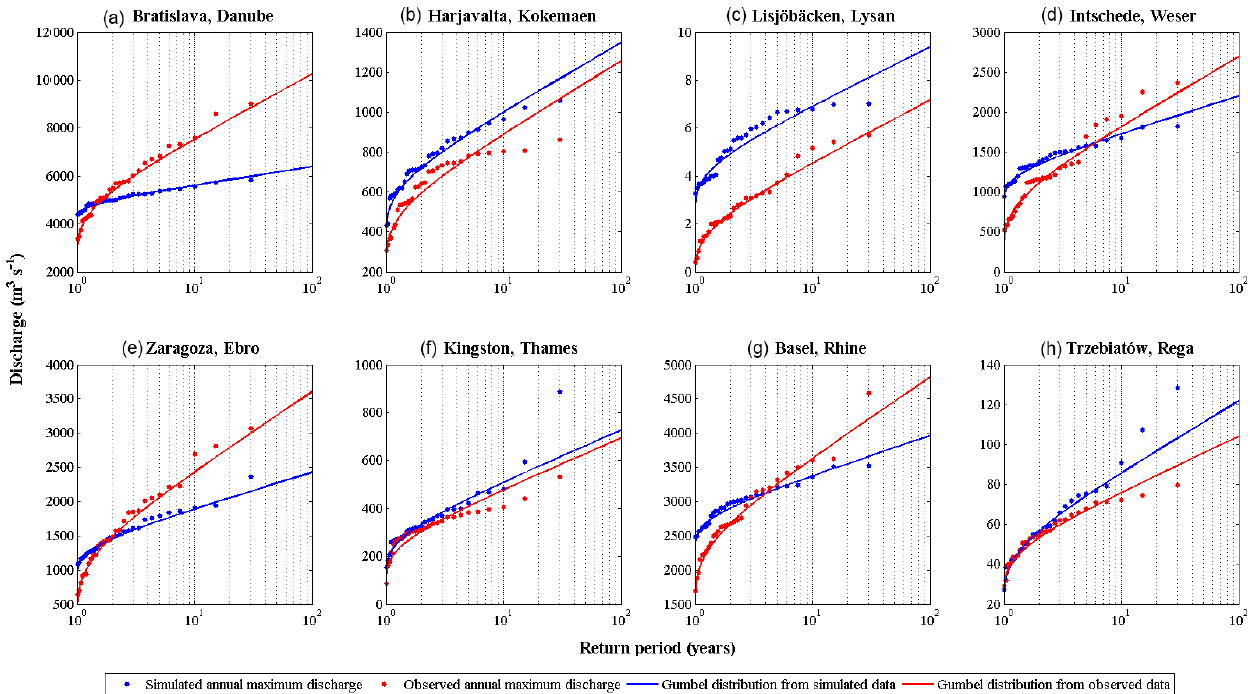
Figure 7. Simulated and observed annual maxima of daily river discharges fitted to Gumbel distribution at selected stations. Data refer to 1971–2000, except for panel (h) , which refers to